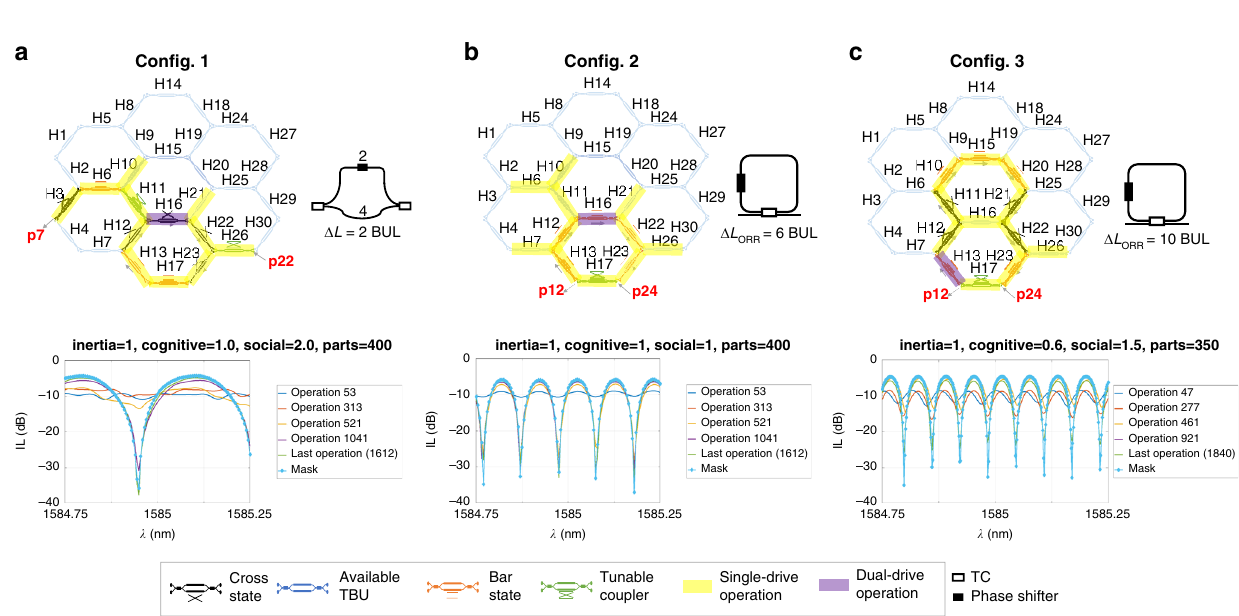
Fig. 4 Examples of statistical results for the self-con fi guration performance evolution of optical fi lter programming. The process employs different spectral masks using particle swarm optimization algorithm with fi xed hyperparameter selection — inertia lineal from 0.9 to 0.35 in 1000 operations — and cognitive: 0.7, and social 1.8 and 108 particles — employing the cost function de fi ned in Eq. (3), CF O.Filter1 and ports 1 – 4 represented in Fig. 3. a – x For each four-plot image group, we evaluate from left to right: (1) self-con fi guration of different spectral masks (squares) without tuning crosstalk and with nonuniform loss, representing the spectral response (solid) with wavelength normalized to unit cell delay, (2) the evolution of the average (solid), maximum and minimum (dotted), and standard deviation (shaded) cost function, and (3) output feature (OF) values. OF1: insertion loss of the passband (dB), OF2: extinction ratio (dB). Each datasheet is composed of 30 independent experiments with different waveguide mesh initial conditions. Note that each example request different periodicity and shapes, y – bb self-con fi guration of different spectral masks (squares) and evolution of the performance with nonuniform unit cell loss and tuning cross talk up to 5%, cc – ff self-con fi guration of different spectral masks (squares) and evolution of the performance with nonuniform unit cell loss and tuning cross talk up to 10%, gg – jj self-con fi guration of different spectral masks (squares) and evolution of the performance with nonuniform unit cell loss and “ damaged ” unit cells A6, B6, and C6 (see Fig. 3 for reference), kk – nn self-con fi guration of two spectral masks simultaneously employing